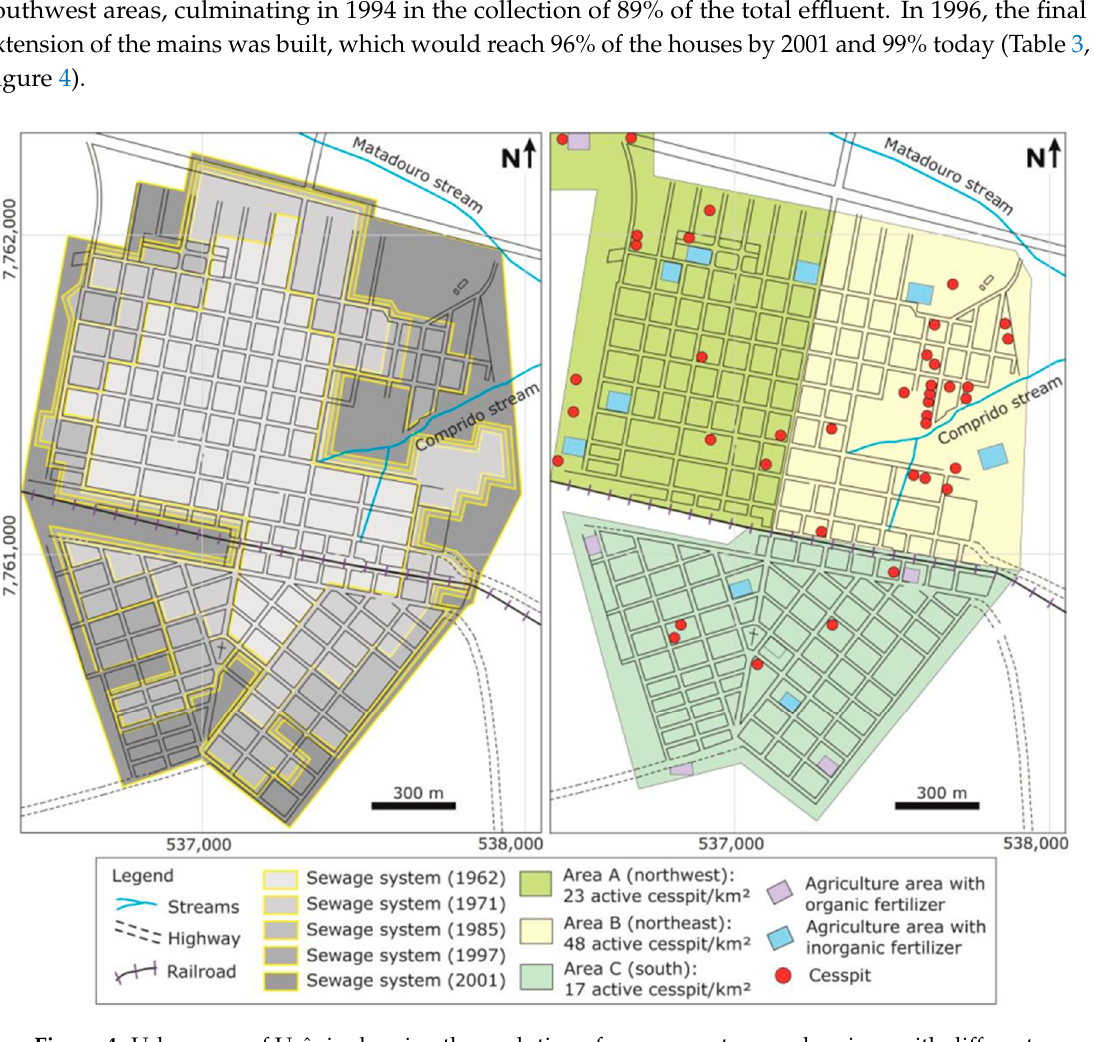
Figure 4. Urban area of Urânia showing the evolution of sewage system; and regions with different densities of cesspit per km 2 with the locations of agricultural areas with types of fertilizers. Agricultural activity in the urban area was identified and mapped on 21 small properties, all of which used organic fertilizers (manure) and only eight of which also used inorganic fertilizers in 1990s. This profile has not changed much over the years (Figure 4).